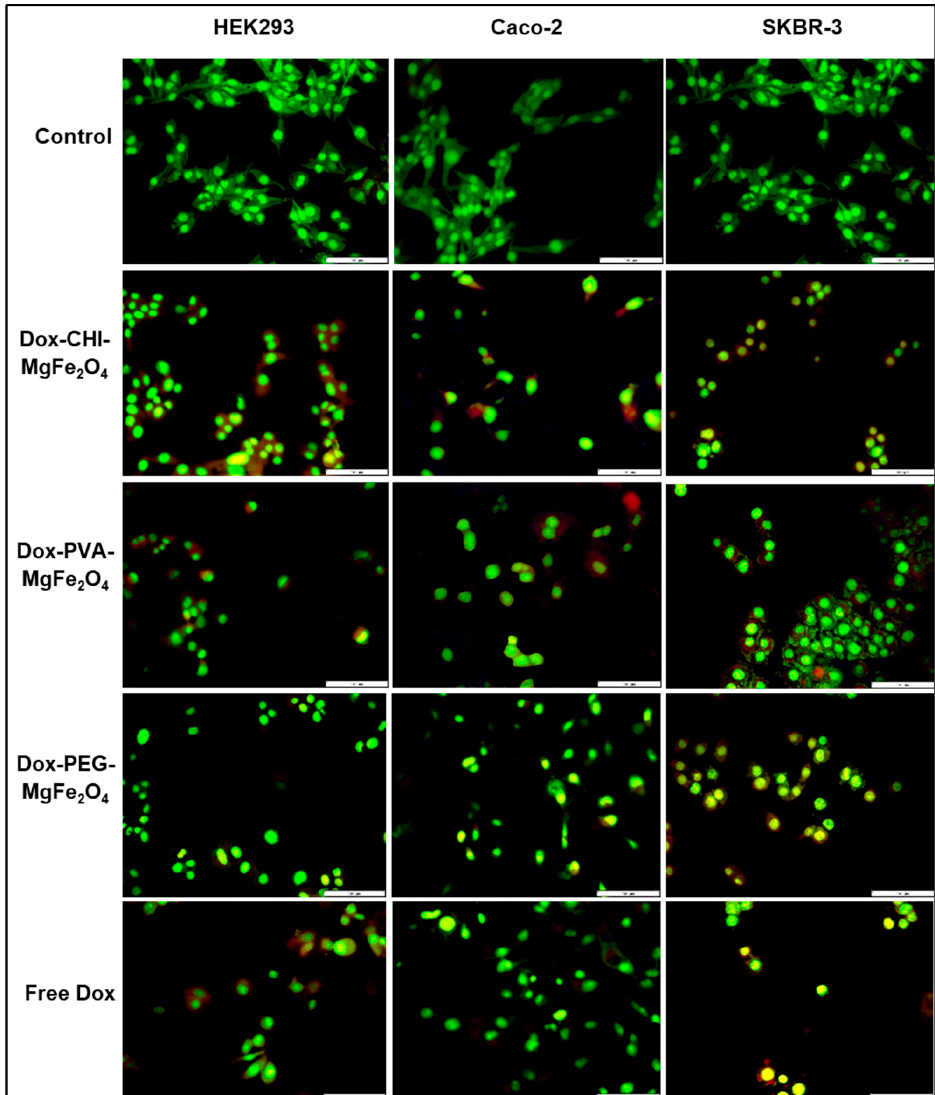
Figure 8. Fluorescent micrographs obtained from the dual AO/EB apoptotic study in the HEK293, Caco-2 and SKBR-3 cell lines at 100× magnification. Bar = 100 µm.